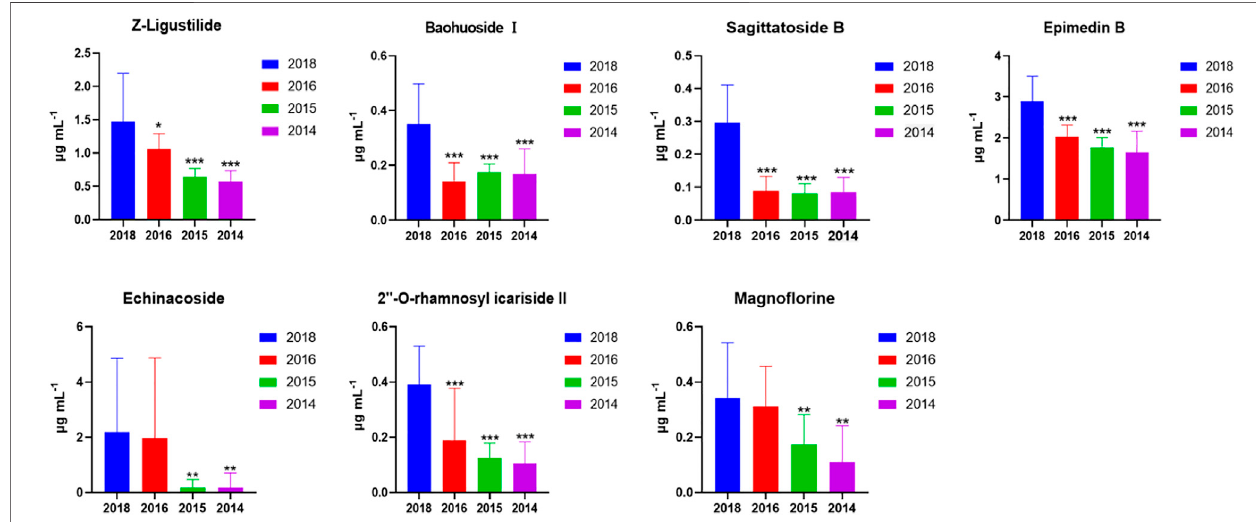
FIGURE 3 | The contents of 7 highlighted components across CHS-J samples produced in different years. Value represents mean ± SD ( n = 20), * p < 0.05, ** p < 0.01, *** p < 0.001 vs. 2018.